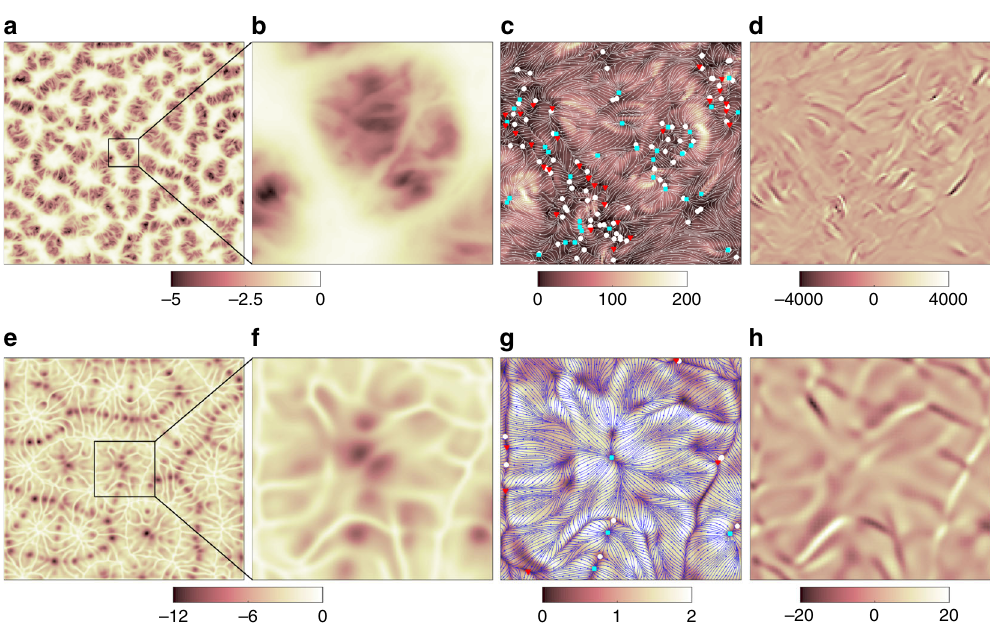
Fig. 8 Instantaneous structure of the temperature derivative ∂ T/ ∂ z and skin friction fi eld s . Results at the bottom plate are displayed in magni fi cation. a – d are for Pr = 0.005 and e – h for Pr = 7. Both data sets are obtained for Ra = 10 5 . a , e show the derivative ∂ T/ ∂ z at the plate z = 0. b , f replot these data in the magni fi ed section. For b − 1.6 ≤ x , y ≤ 1.6 and for f − 3.1 ≤ x , y ≤ 3.1 are taken. c , g display the fi eld lines of the skin friction fi eld and the critical points as symbols. White circles correspond to saddles, cyan squares to unstable nodes or foci and red triangles to stable nodes or foci. The colored background stands for the magnitude s = | s |. d , h show contours of the divergence of the skin friction fi eld. Sizes of c , d are the same as b and those of g , h are the same as